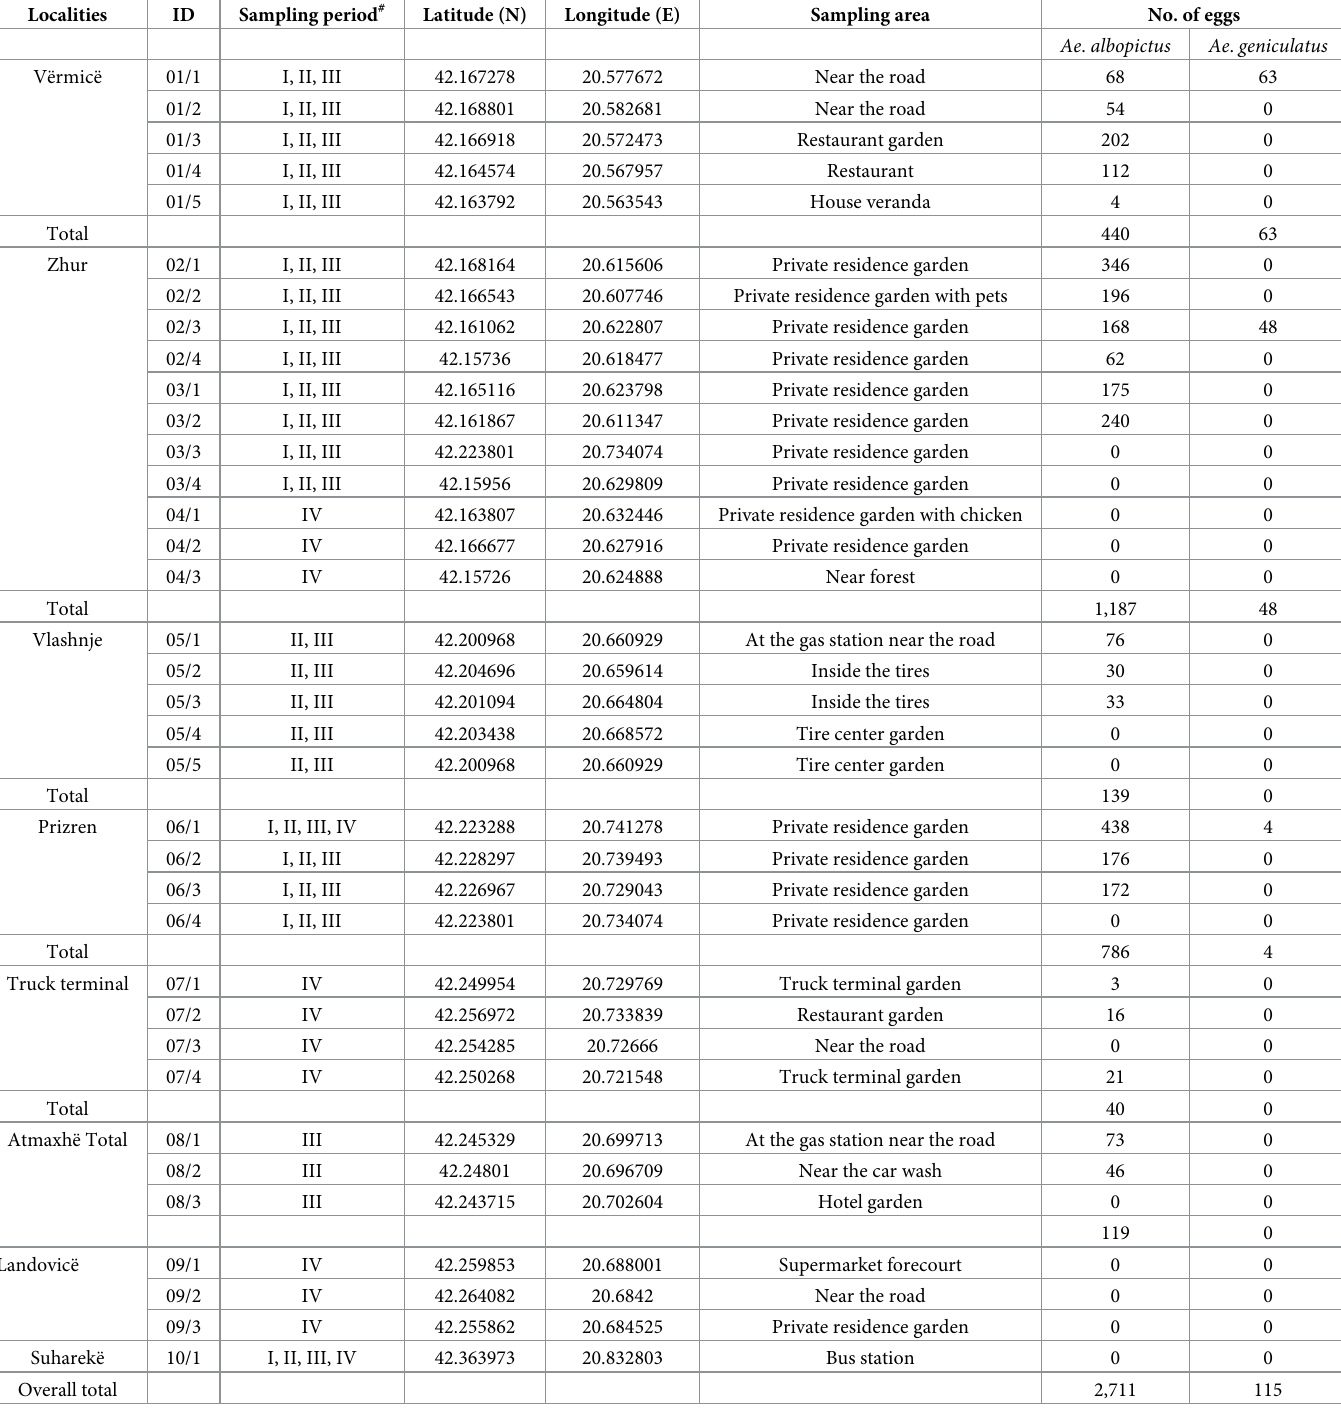
Table 2. Location of ovitraps in the Prizreni municipality and numbers of eggs collected for Aedes albopictus and Aedes geniculatus .